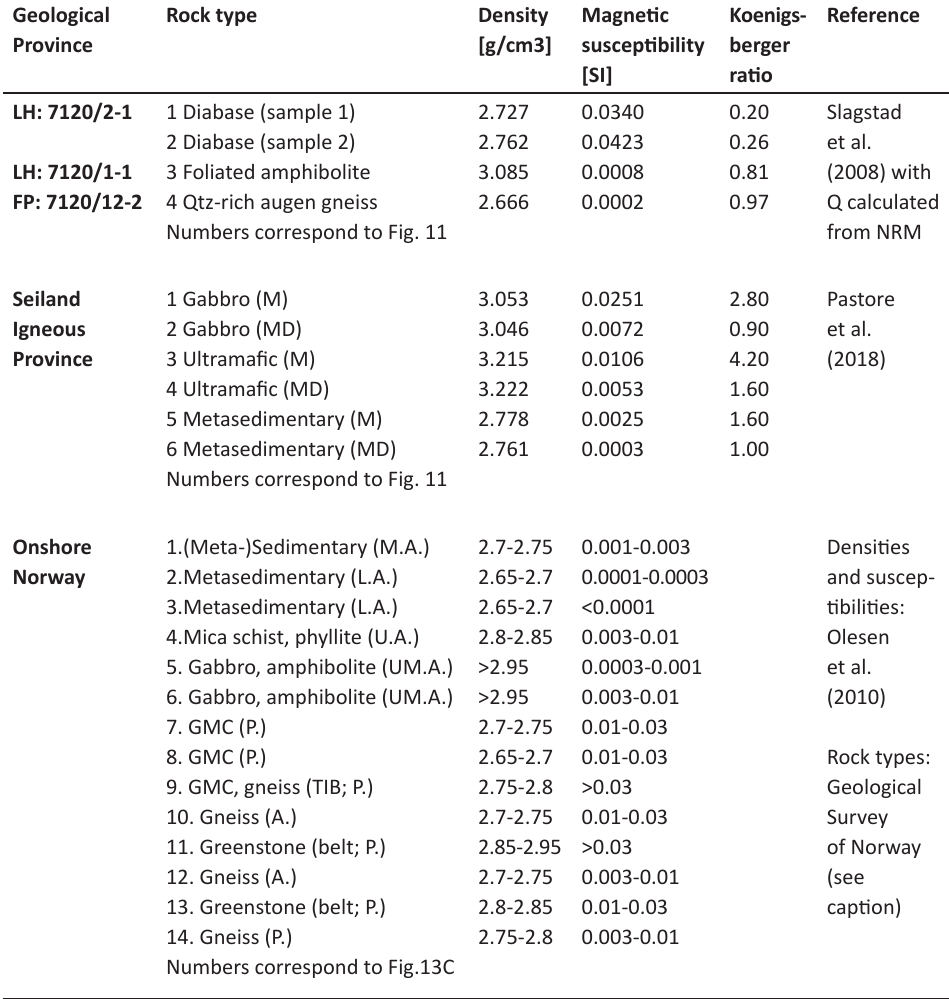
Table 3. Compilation of densities and magnetic susceptibilities of onshore rocks and offshore well cores. Geological survey of Norway: www.ngu.no/emne/kart-pa-nett “Berggrunn 1:250,000 vektor (Gammel)” visited 11.01.2022). M–arithmetic mean value, MD–median value, Q–Koenigsberger ratio; “A.”–Archaean, FP–Finnmark